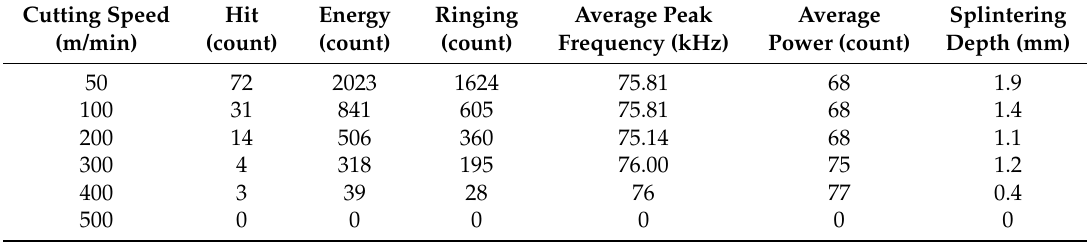
Table 3. AE statistics of splintering cluster under different cutting speeds.